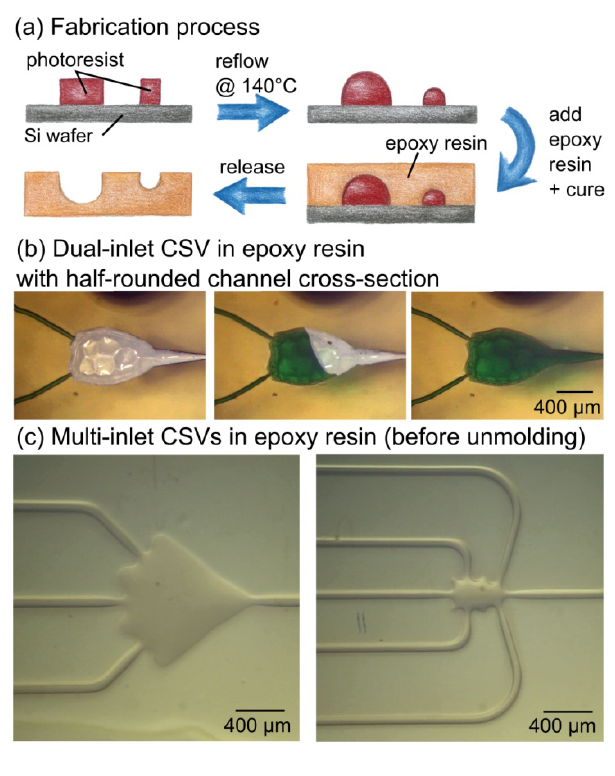
Figure 4. Advanced CSVs having half-rounded cross-sections. ( a ) Fabrication process of microfluidic channels with half-rounded cross-sections. ( b ) Dual-inlet CSVs and their filling behavior with green colored liquid. ( c ) Multi-inlet CSVs in epoxy